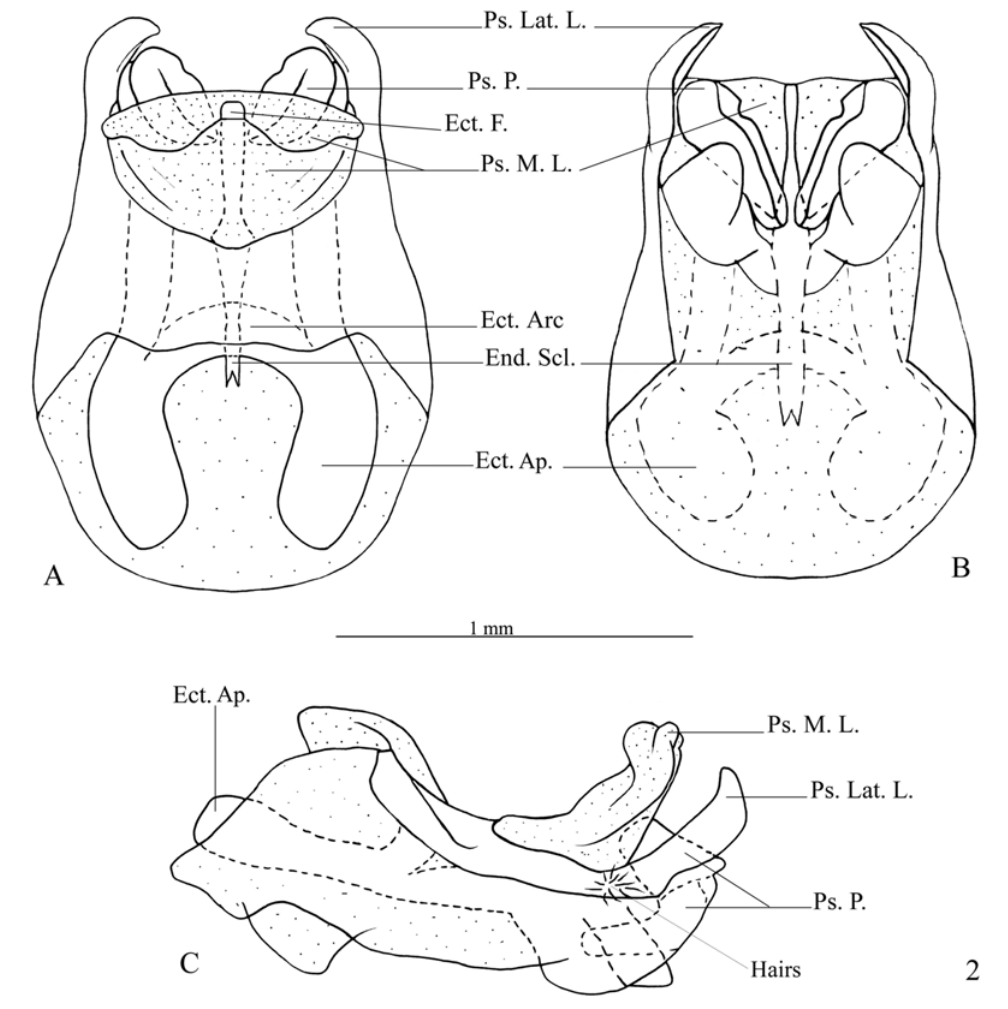
Fig. 2 – Male genitalia of P. arenita sp. nov. in A. dorsal, B. ventral and C. lateral view. Abbreviations: Ps. Lat. L.: pseudepiphallic lateral lobes / Ps. P.: pseudepiphallic paramere / Ps. M. L.: pseudepiphallic median lobe / Ect. F.: ectophallic fold / Ect. Arc: ectophallic arc / Ect. Scl.: ectophallic sclerite / End. Ap.: endophallic